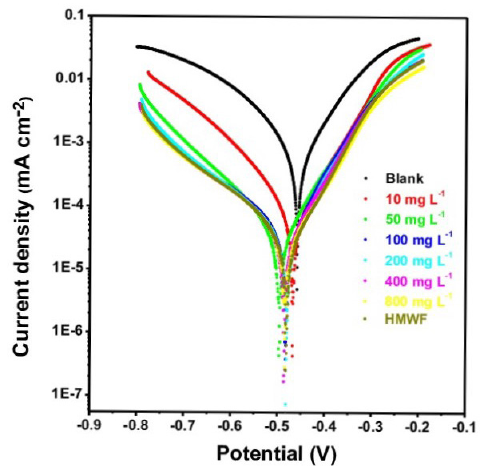
Figure 7. Polarization curves of mild steel in 1 mol L −1 HCl in the absence and presence of different concentrations ACSE and at 400 mg L −1 of its